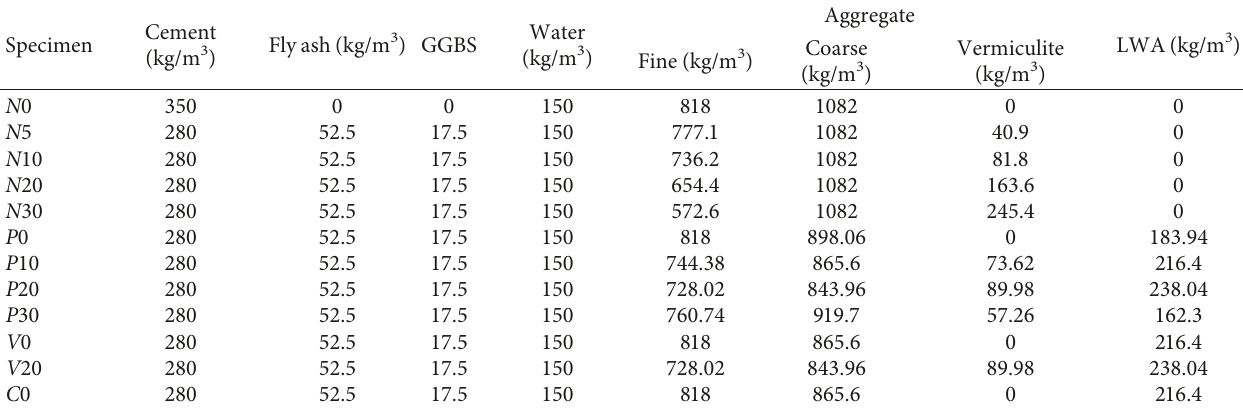
Table 3: Mixture proportions.